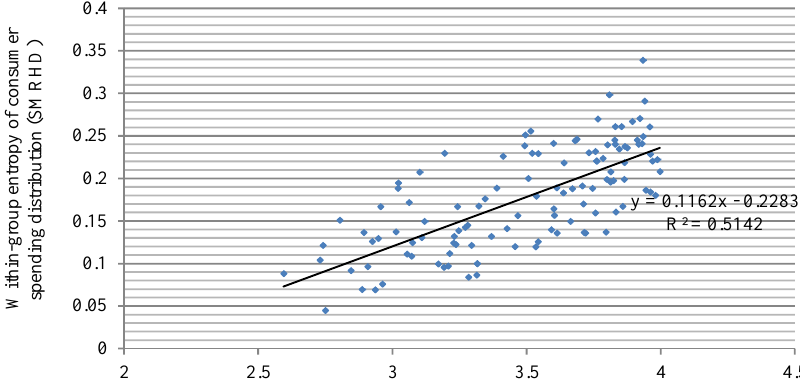
Figure 11. Linear regression for link "the absolute size of consumer spending — a measure of diversity of consumer spending (within-group entropy for SMRHD)" for 115 countries with lowest household spending